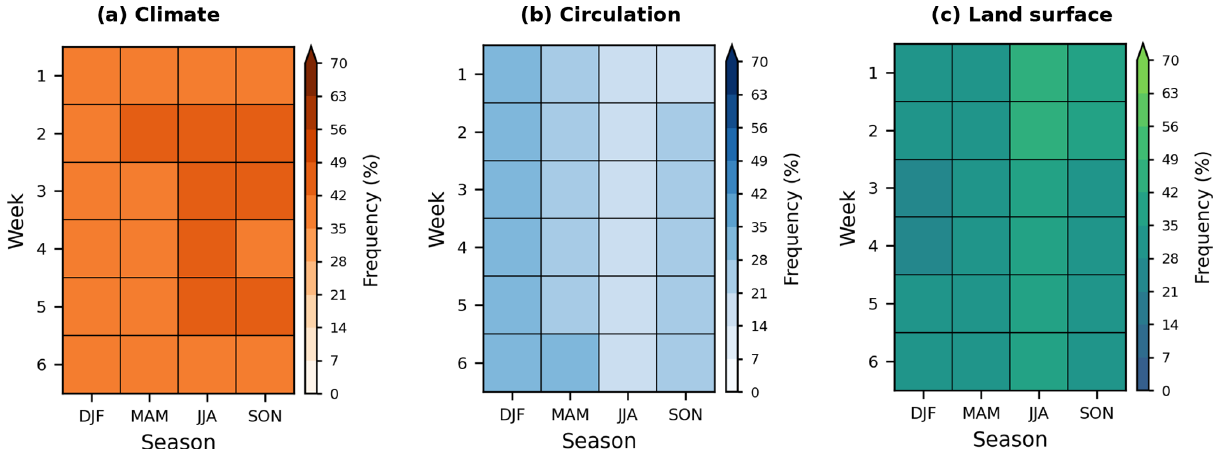
Figure A4. Fraction of grid cells (%) where each group of Earth system variables is the most relevant across lead times ( y axis) for each season ( x axis).